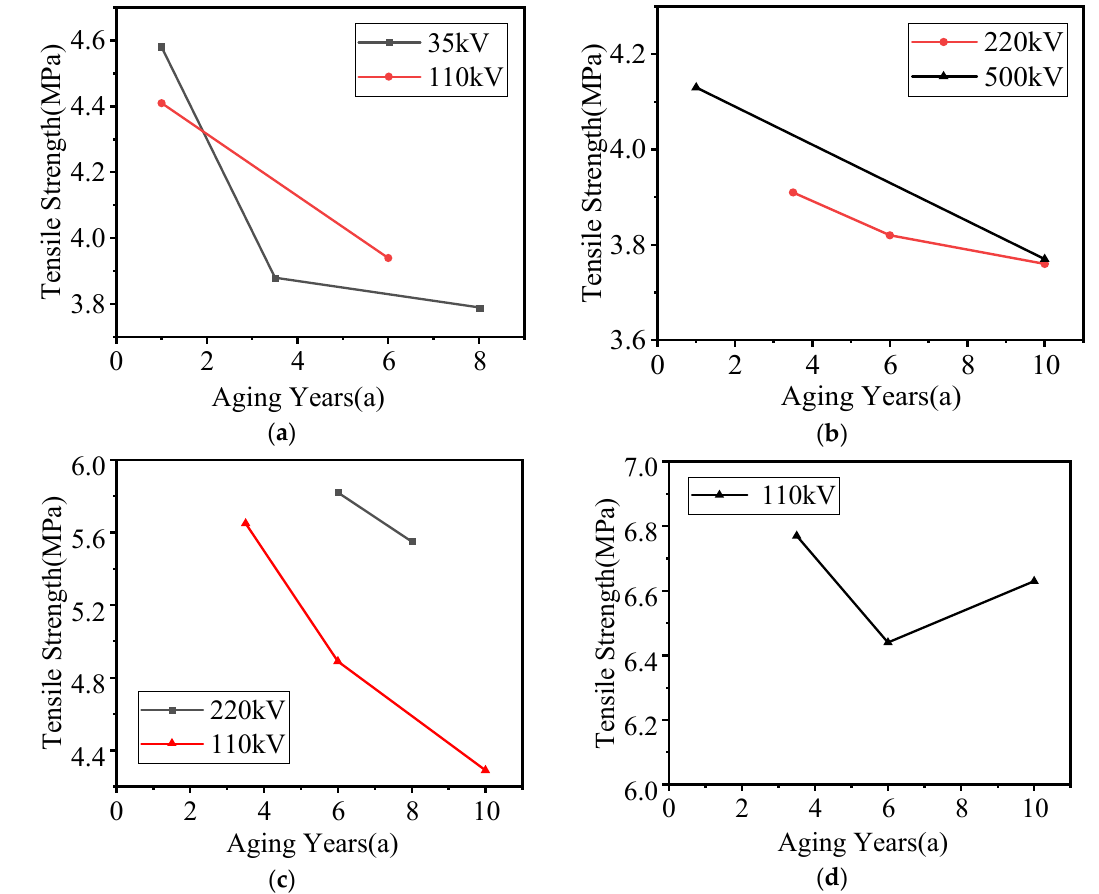
Figure 10. Variation of samples’ tensile strength with years of aging: ( a ) Factory A, ( b ) factory B, ( c ) factory C, ( d ) factory D.